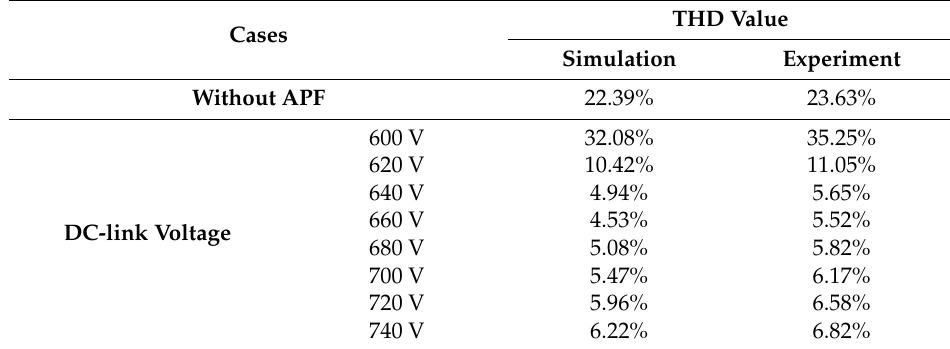
Table 3. Comparison of THD values with different DC-link voltages.